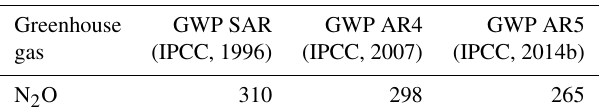
Table 4. Global warming potential (GWP) relative to CO 2 (dimen-